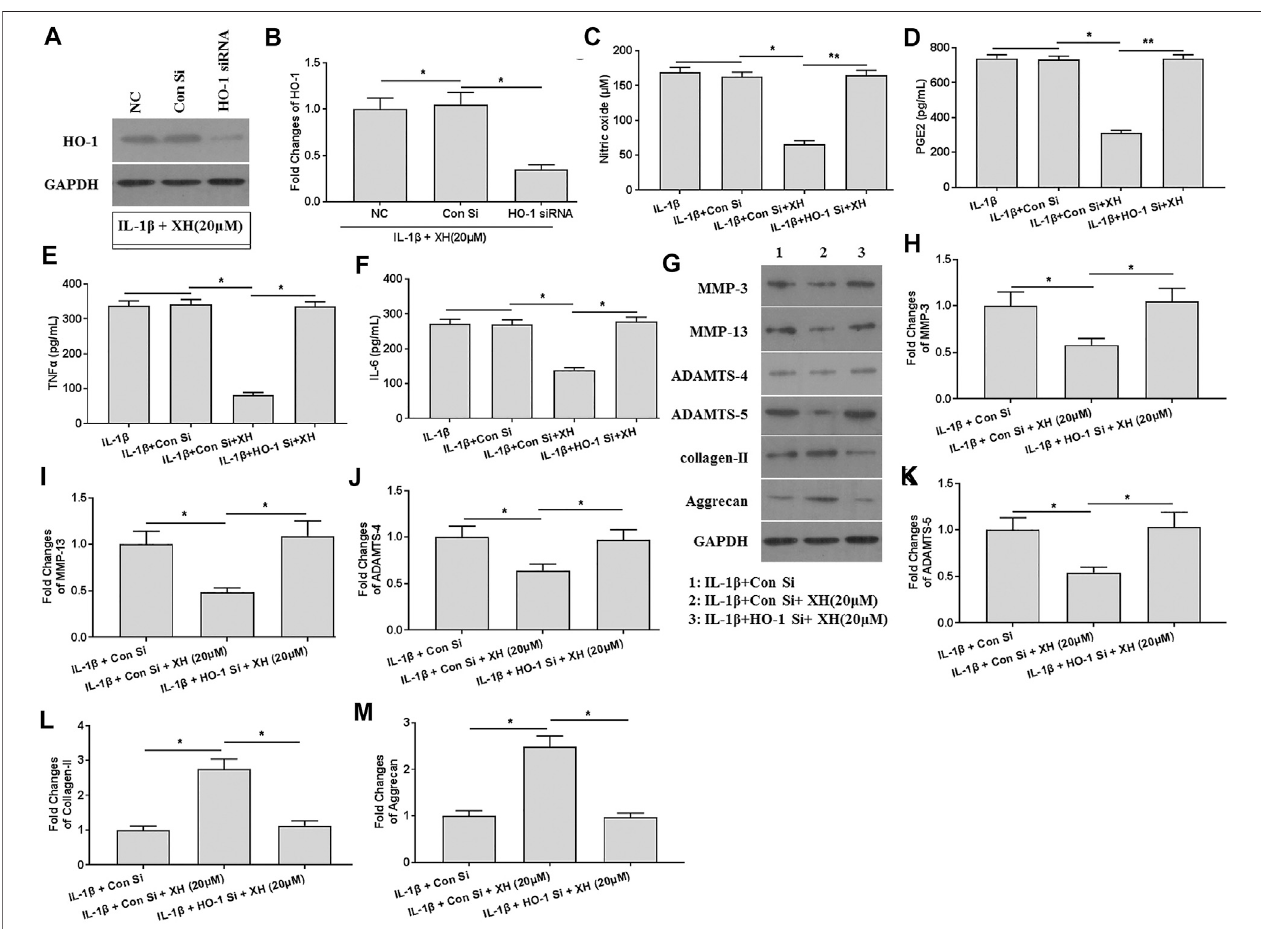
FIGURE 6 | XH attenuated ECM degradation induced by IL-1 β via up regulation of HO-1 in chondrocytes. (A) The expression of HO-1 was detected in HO-1 siRNA-transfectedchondrocytes. (B) Thequanti fi edvaluesoftestedproteinwereindicated.Theproductionsofin fl ammatorycytokinesNO (C) ,PGE 2 (D) ,TNF α (E) ,and IL-6 (F) inHO-1siRNA-transfectedchondrocytesweredeterminedbyELISA. (G) TheproteinsexpressionofMMP-3,MMP-13,ADAMTS-4,ADAMTS-5,collagen-II,and aggrecan were detected in HO-1 siRNA-transfected chondrocytes. (H – M) were the quanti fi ed values of tested proteins. All experiments were performed in triplicate and data are presented as the mean ± standard deviation. * p < 0.05 and ** p < 0.01. NC, negative control; Con Si, control siRNA.